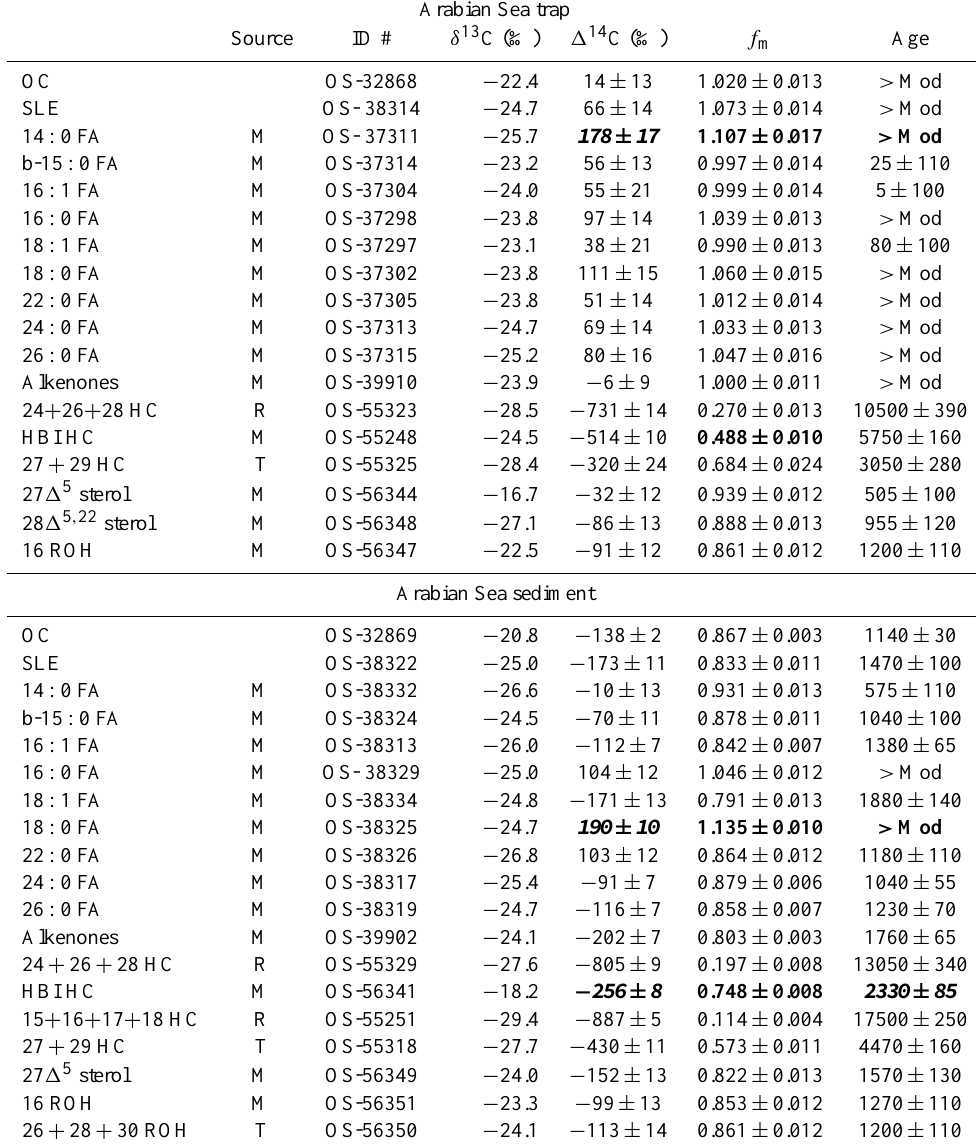
Table 2. Stable carbon and radiocarbon isotope data for Arabian Sea POM and SOM. Bold italicized values were not used in calculations (see